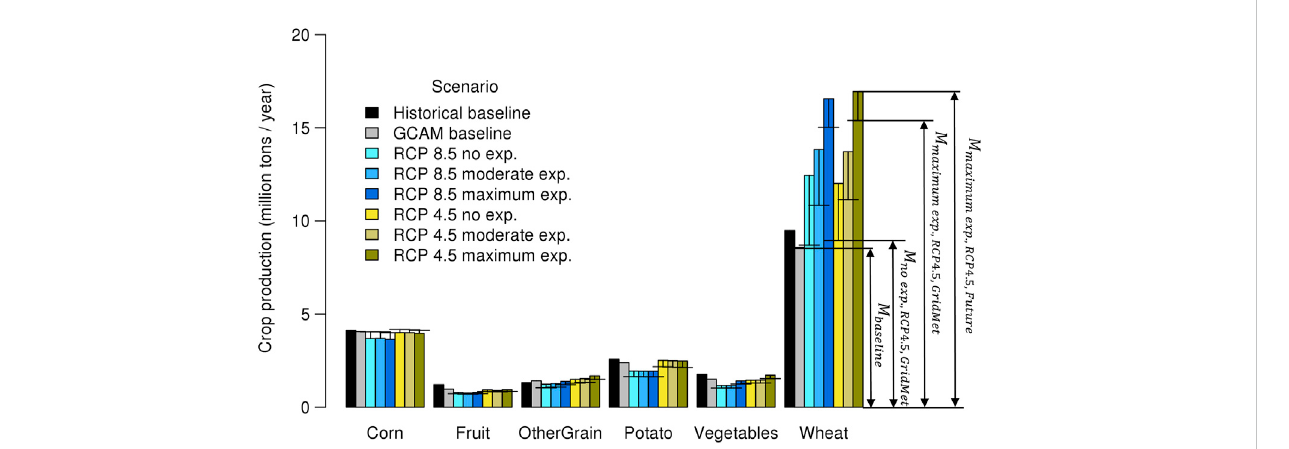
FIGURE 7 Annual crop production for major food crops in the extended CRB. Total production, both irrigated and dryland, was aggregated from CropSyst crop typestothesixcropgroups,andthemedianannualproductionforeachcropgroupwascalculatedovertheappropriate30-yrtimeframeforfuturescenarios (2046 – 2075) or baseline scenarios (1986 – 2015). The black horizontal line within (or above) each column marks the crop production value for that scenario using historical GridMet/Livneh climate data. The distance measurements show each component used to calculate Δ Clim , Δ Irr , Δ LU , and Δ Total as per Eqs 17 – 20, using RCP 4.5 maximum expansion as an example. Results shown do not account for curtailment impact on irrigated yields.